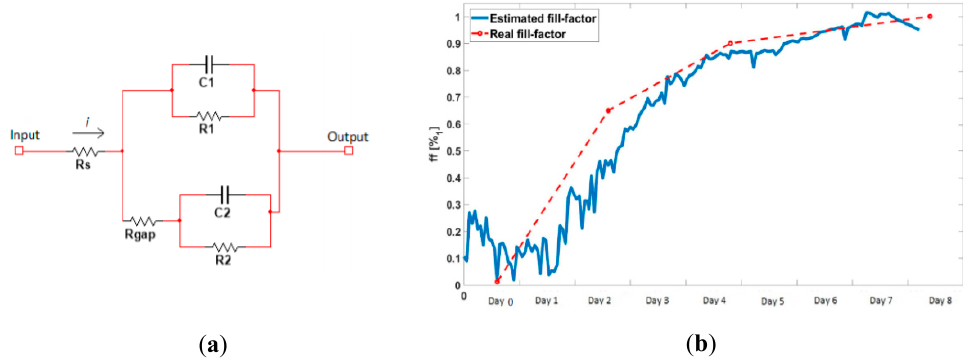
Figure 7. Electrical model of the cell culture and electrode system in non-differentiated wells. ( a ) The different electrical parameters (R s , R gap , R 1 , C 1 , R 2 and C 2 ) are defined following [12,16]. ( b ) Comparison of actual experimental fill factors obtained in the experiments (corresponding to the experimental visual inspection of well 2) and the fill factor obtained by the electrical model for cell culture growth (without differentiation).